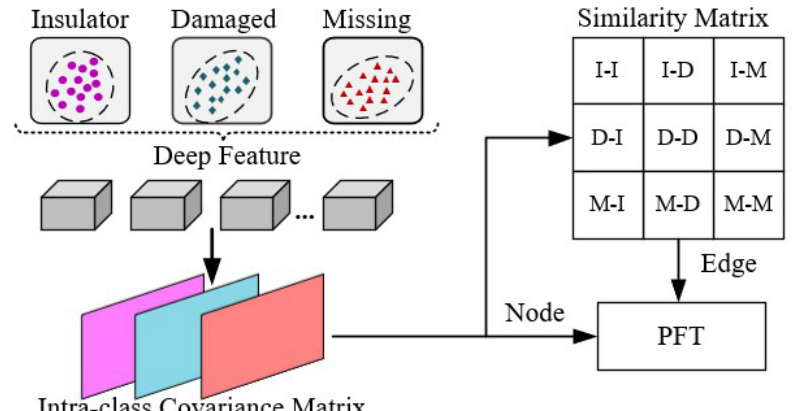
Figure 3. Architecture of the AGR model.